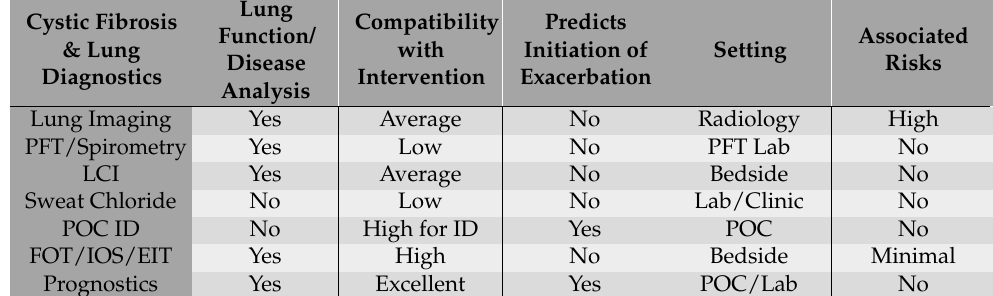
Table 2. Advantage of respiratory diagnostics for cystic fibrosis. PFT: Pulmonary Function Test, PET: Positron Emission Tomography, FOT: Forced Oscillation Technique, IOS: Impulse Oscillometry System, EIT: Electrical Impedance Tomography. Lung Diagnostic Advantage for CF Thoracic X-Ray Thoracic